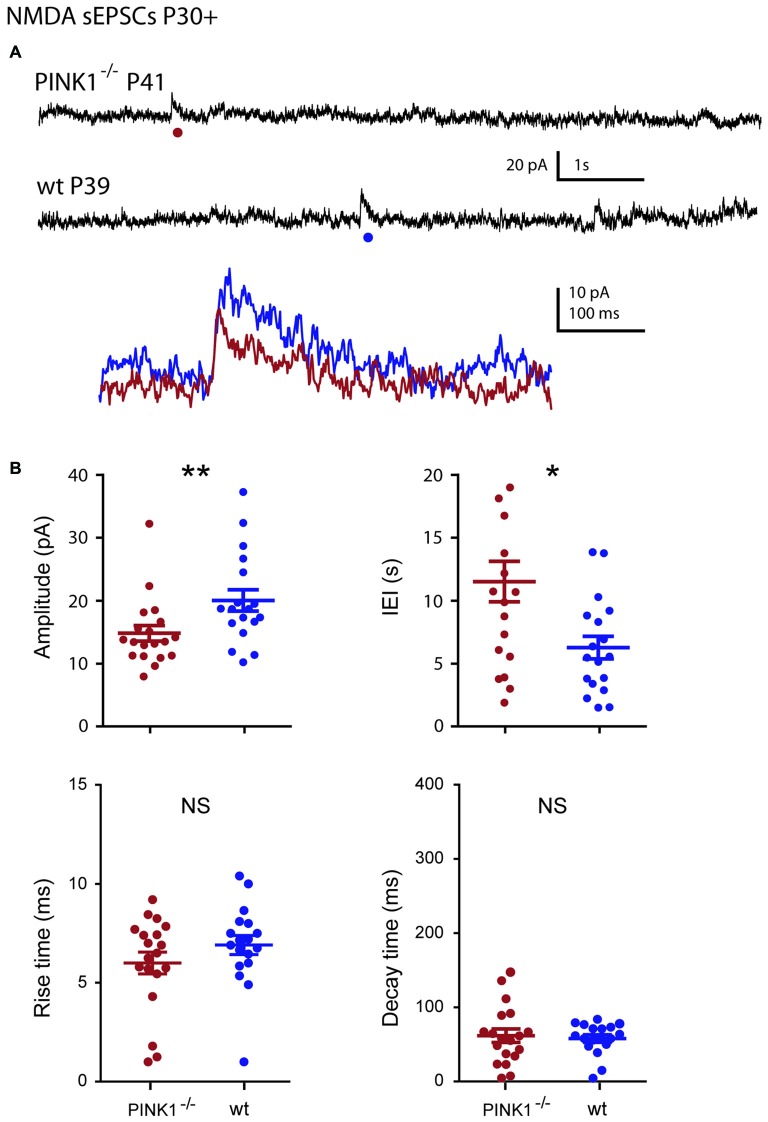
Single NMDA sEPSCs in young adult (P30+) pink1−/− SNc DA neurons and comparison with age-matched wt SNc DA neurons. (A) Voltage-clamp recordings of NMDA sEPSCs from a P41 pink1−/− (red) and a P39 wt (blue) SNc DA neuron in the continuous presence of gabazine (5 μM) and NBQX (10 μM) at VH = +40 mV. The NMDA events indicated by a dot are enlarged and superimposed in the inset. (B) Quantification and statistical comparison of the amplitudes and IEIs and of the rise and decay times of P30+ pink1−/− (n = 19) and wt (n = 18) NMDA sEPSCs, as indicated.